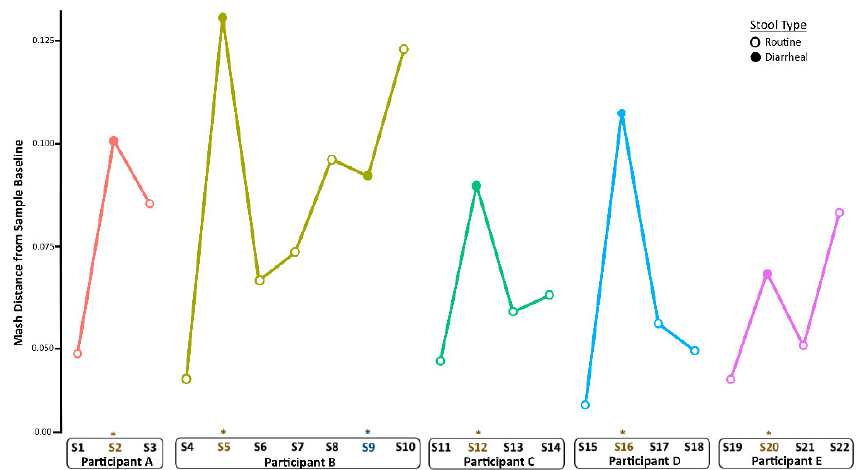
Figure 3. Longitudinal changes in taxonomic diversity measured by Mash distance. Metagenome composition increased from baseline (pre-infection) levels during norovirus infection and decreased in the weeks after recovery from AGE for all children. An * and brown colored text represent the samples collected during the AGE episodes. For Patient B, a second norovirus infection occurred, indicated by the blue text. Numbers following “S” indicate the sample identifier for metagenomic data.